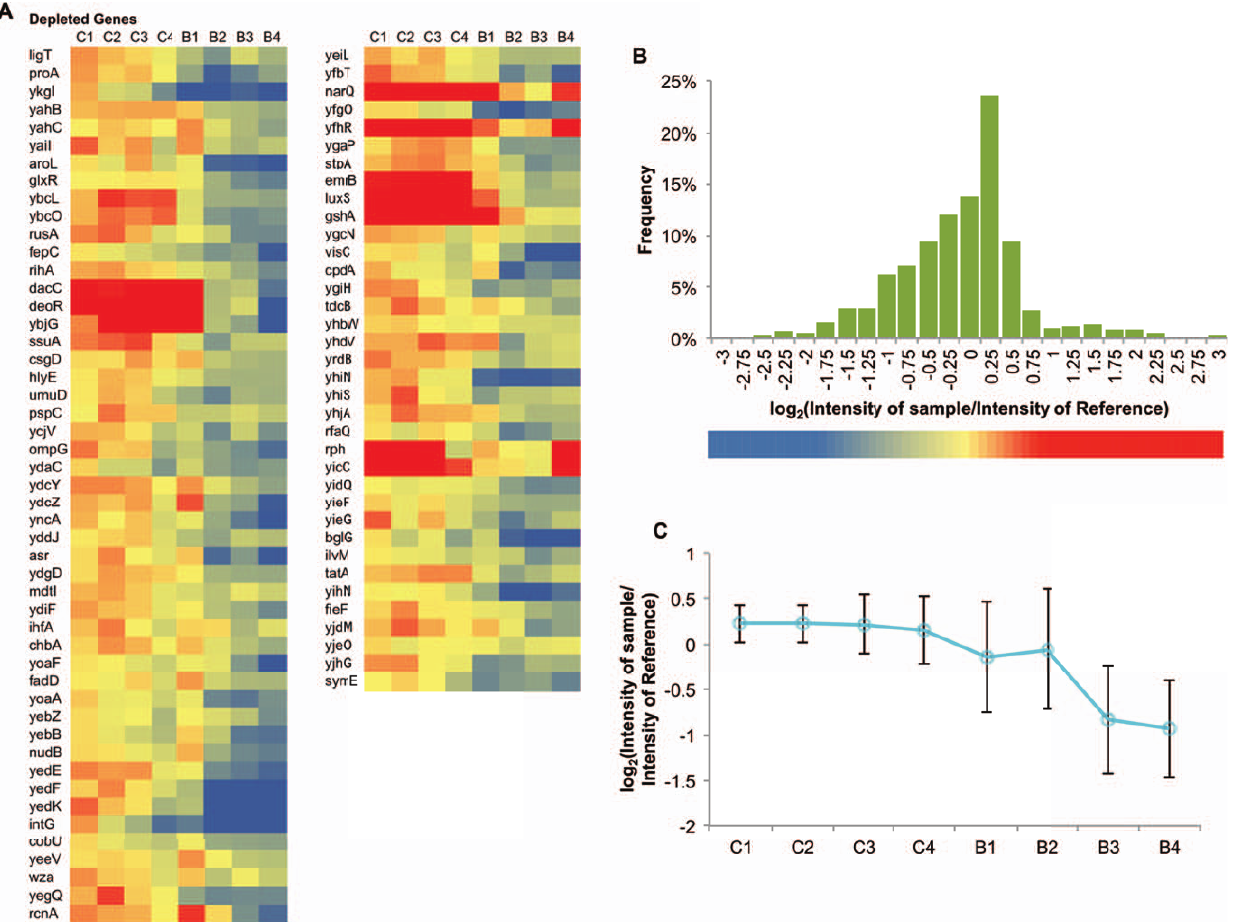
Figure 2. Profiles of genes significantly depleted in the n-butanol challenge. A . Heat map of all genes depleted. B. Histogram of the range of normalized log 2 (Intensity of sample/Intensity of Reference . The colored bar at the bottom part of the figure is the legend for Figure 4A. C. The averaged